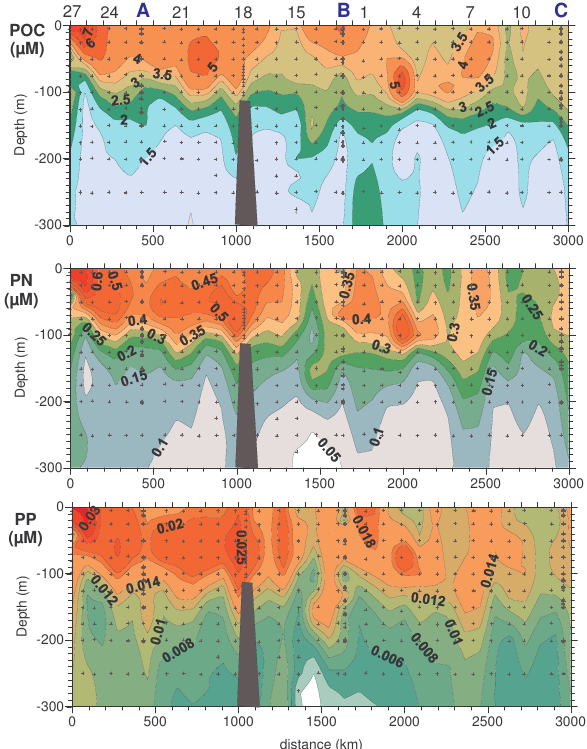
Figure 6. Surface (0-300 m) vertical sections of Particulate Organic Carbon (POC), Nitrogen (PN) 2 Fig. 6. Surface (0–300m) vertical sections of particulate organic and Phosphorus (PP) along the BOUM transect (Deep sections not shown). On the top X-axis, the 3 carbon (POC), nitrogen (PN) and phosphorus (PP) along the BOUM position of the stations is indicated. 4 transect (deep sections not shown). On the top x-axis, the position of the stations is indicated.